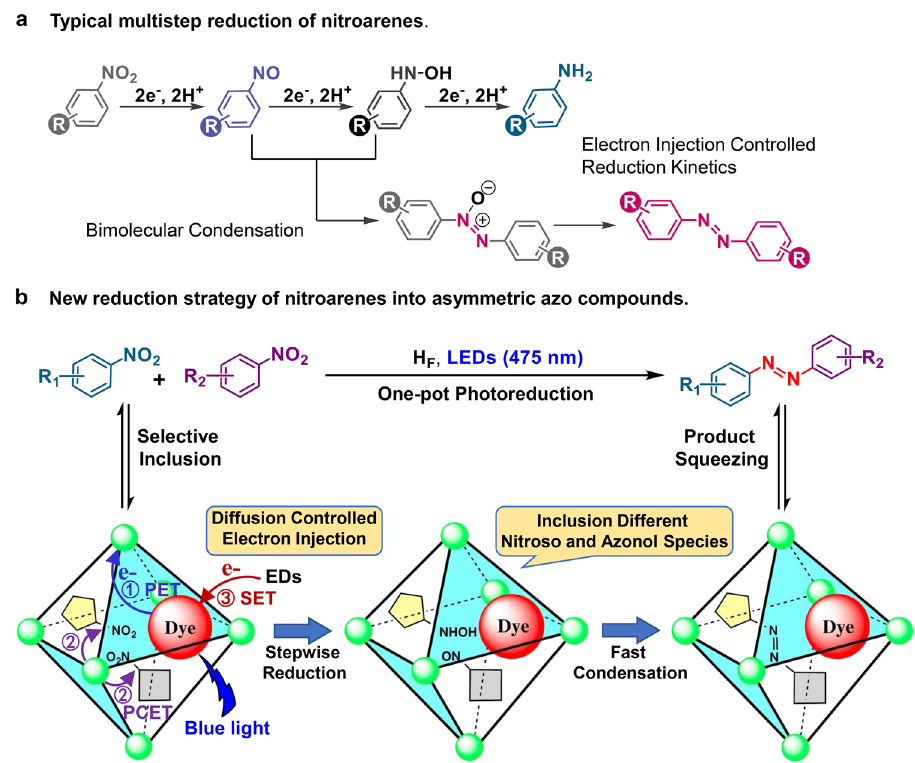
Fig. 1 Schematic of typical reduction of nitroarenes and one-pot photoreduction of nitroarenes in dye-loaded catalyst H F system. a Typical reduction pathways of nitroarenes for amino and azo products. b The one-pot photoreduction of nitroarenes into asymmetric azo products using the dye-loaded catalyst H F , showing the proposed electron transfer sequence: initialed from the photoinduced electron transfer (PET) from the excited state of dye to the metal center, then the proton coupled electron transfer from the reduced metal center to the substrate (PCET), followed by the single electron transfer (SET) from the electron donor to the oxidized dye, recovering the organic dye for another